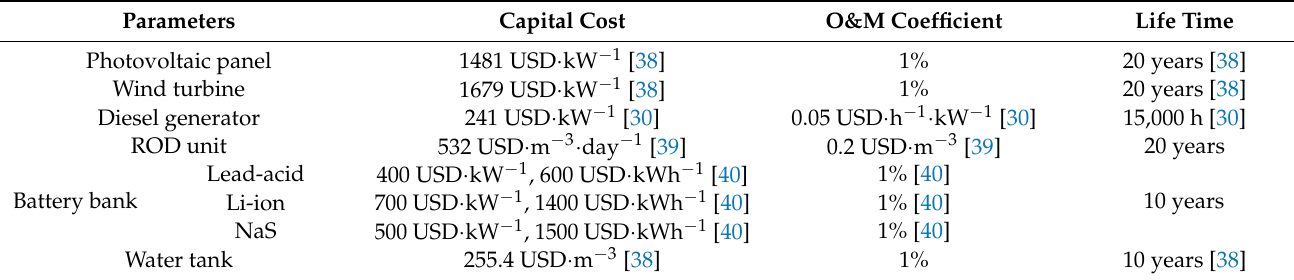
Table 2. Optimal results of the system. Table 1. Parameters of the system.